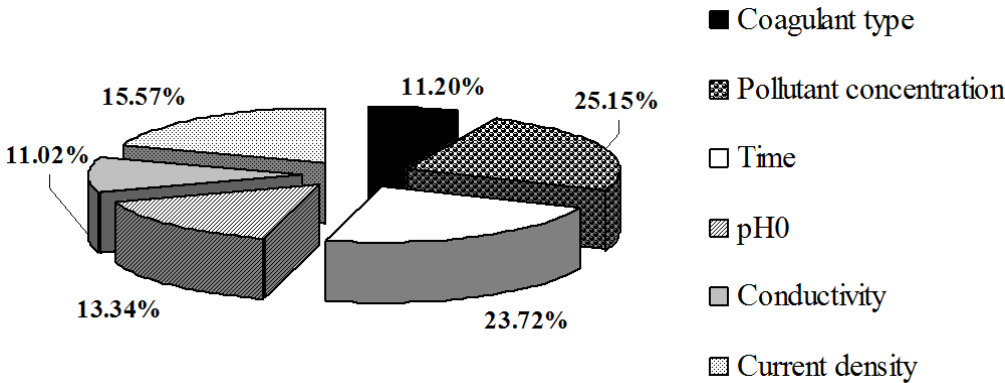
Figure 4. The percentage hierarhy of the neural network inputs upon their influence on the network output for the electro-coagulation